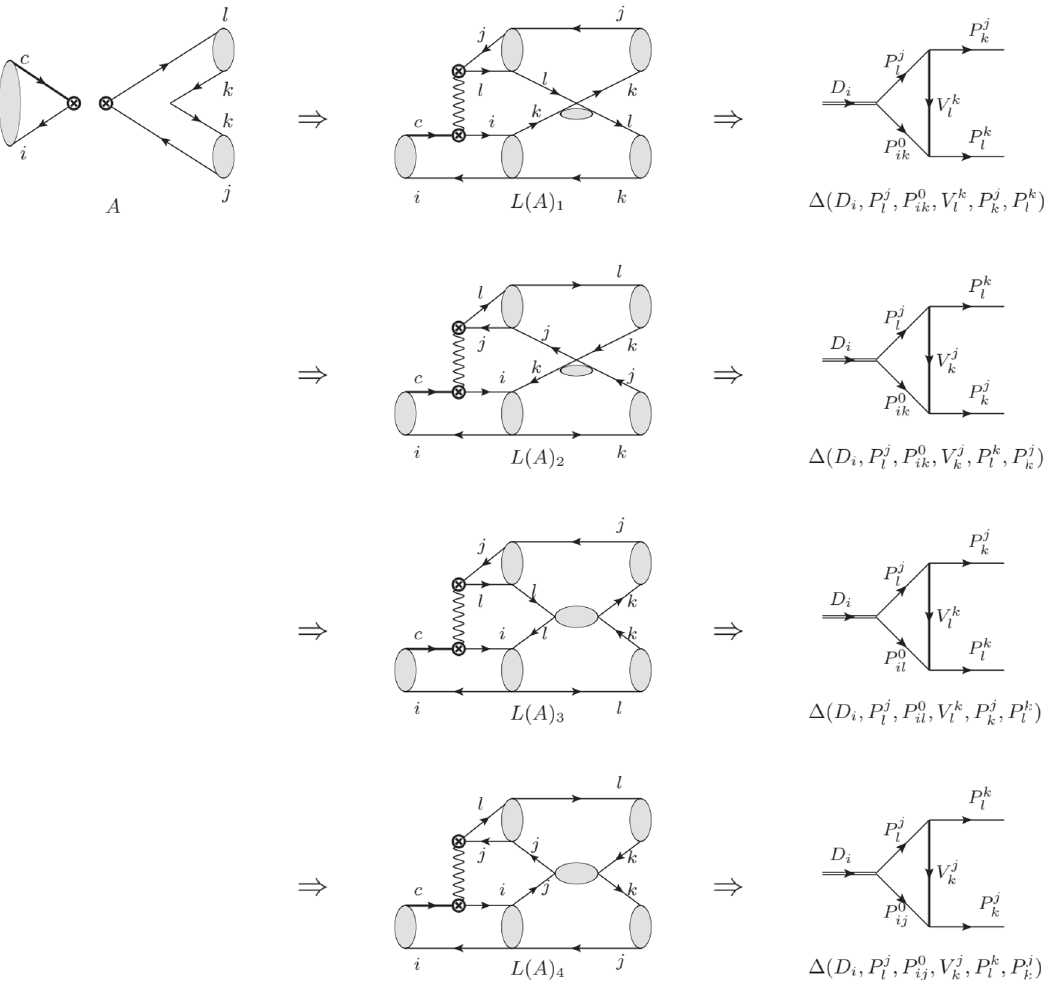
Figure 9 . Topological diagram ⇒ Topological-scattering diagram ⇒ Triangle diagram in T ⇒ A